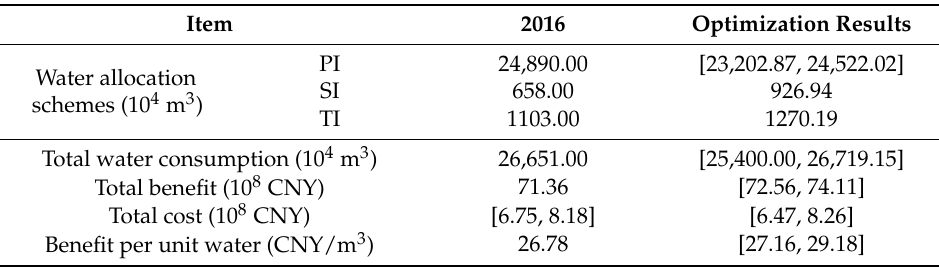
The key parameters comparison between the water allocation scheme in 2016 and optimization